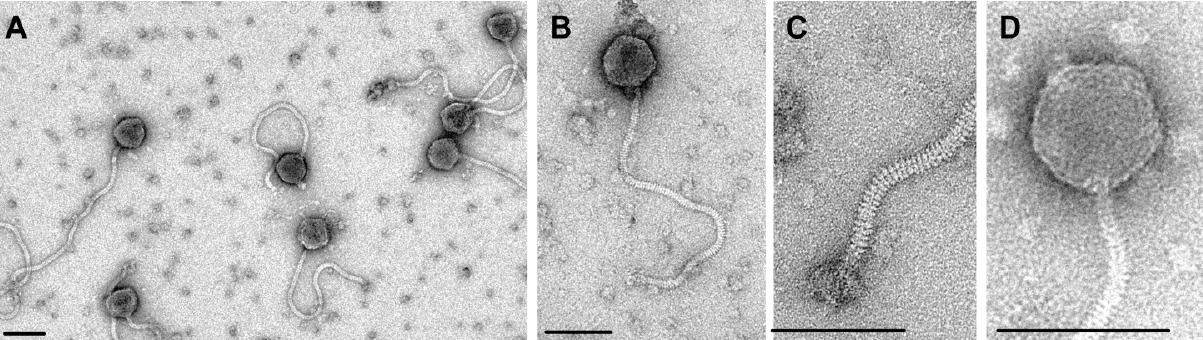
Figure 3. Transmission electron micrographs of phage of phage vB_BanS-Tsamsa particles negatively stained with 2% uranyl acetate on carbon-coated copper